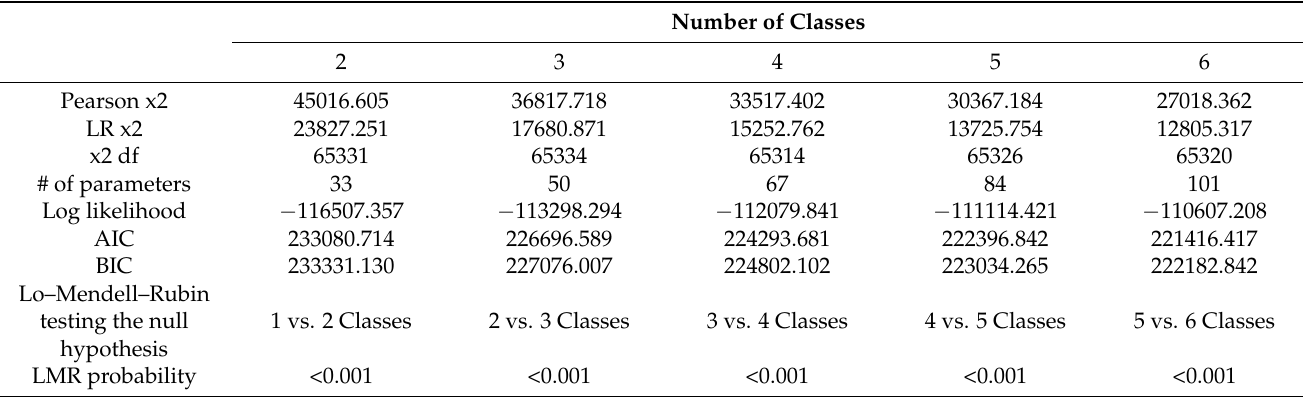
Table 2. The model-fit indices for the latent class